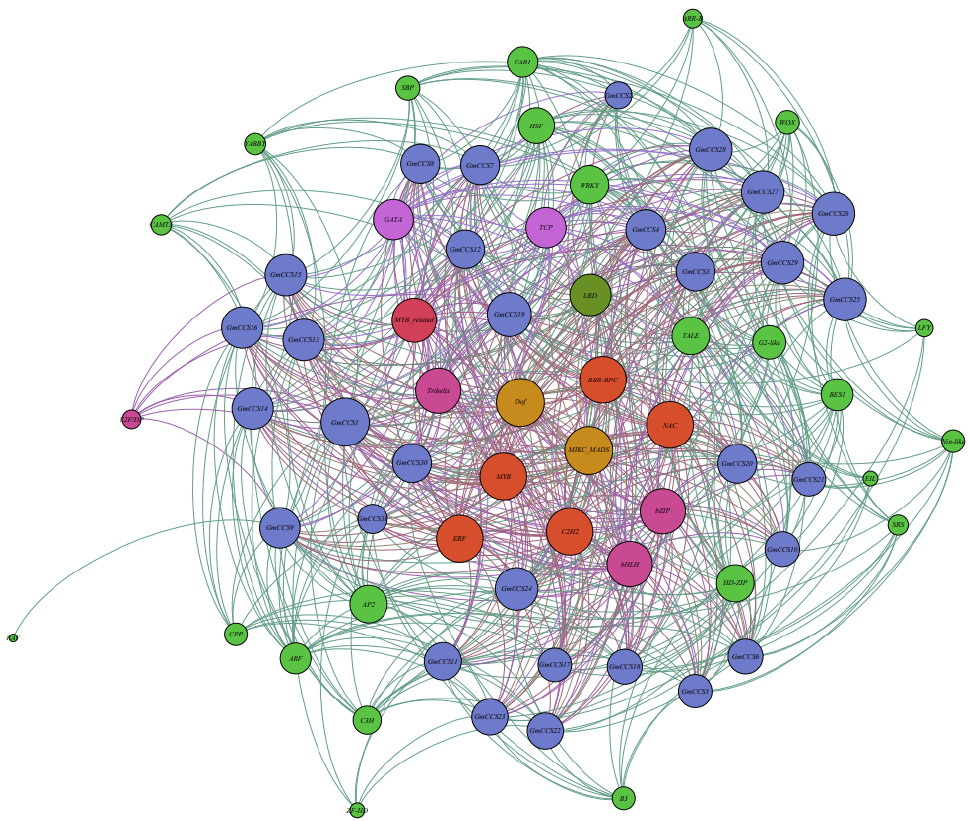
Figure 5. Interacting network among GmCCS family and their potential predicted TFs/protein. The blue cycle represents the GmCCSs gene, the circles with different colors represent different TFs, the lines indicate the relationship between different TFs.